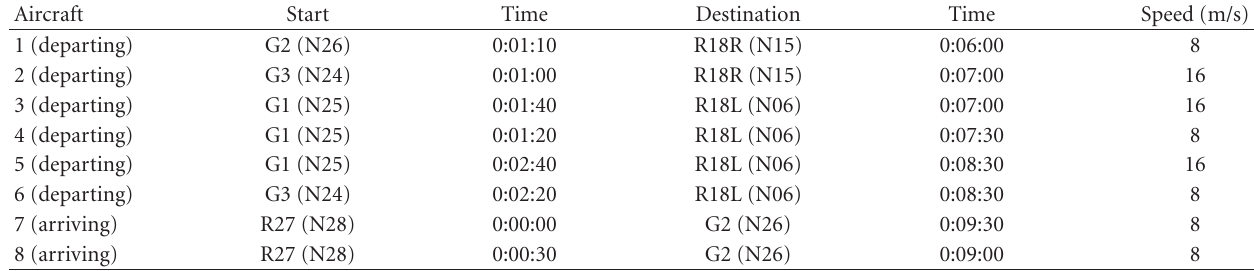
Table 2: List with the departing and arriving aircraft, the taxi speed, the starting point (departure gate or arrival runway), the destination point (arrival gate or departure runway), the start time (earliest pushback time or runway arrival time), and the destination time (latest gate arrival time or allocated runway departure